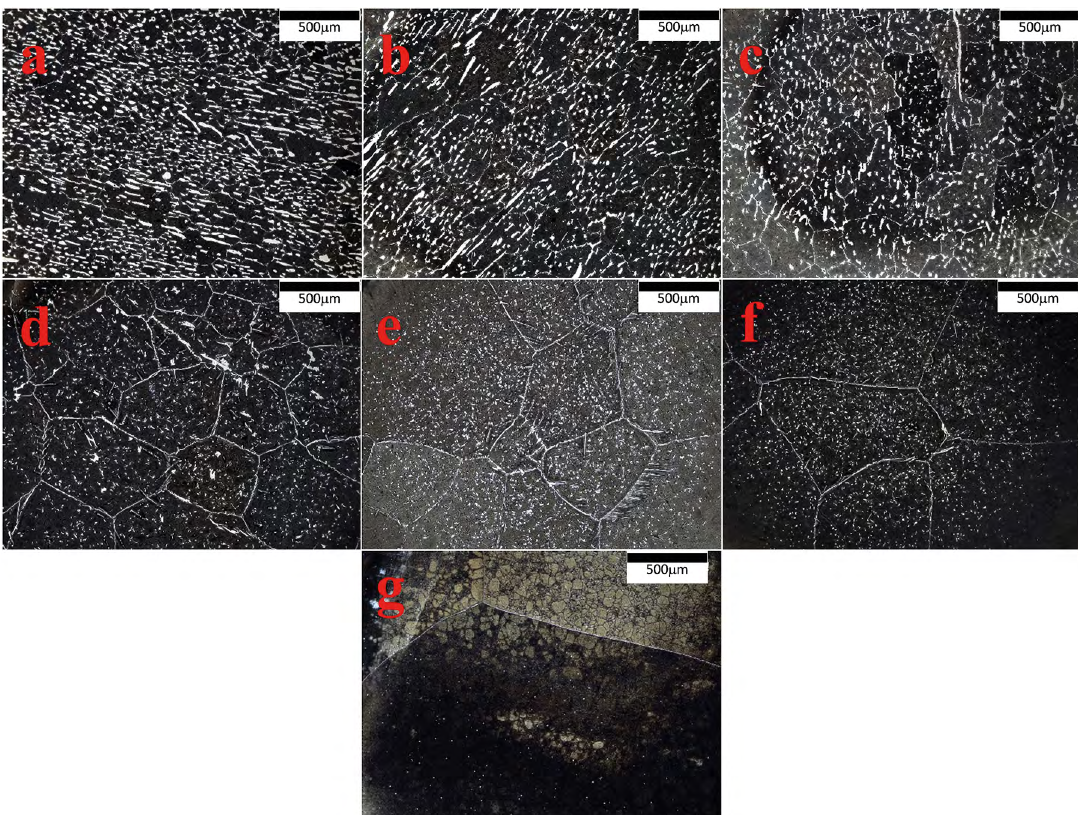
Figure 8. Micrographs of samples held at 1300ºC for different time intervals (highlighting ferrite grain sizes). (a) 1s; (b) 5s; (c) 15s; (d) 30s; (f) 60s; (g) 120s; (h) 300s. OM-50x. Behara II.